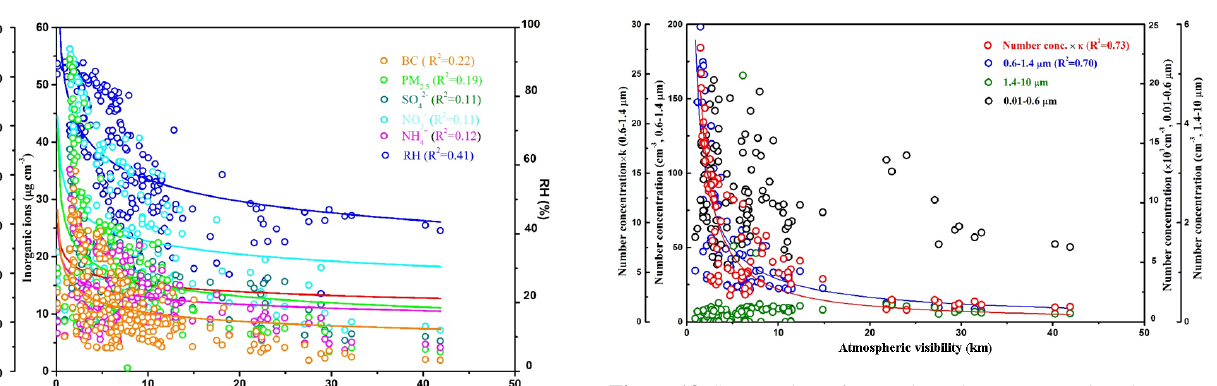
Figure 13. Scatter plots of aerosol number concentrations in ranges of 0.01–0.6, 0.6–1.4 and 1.4–10µm, and aerosol number concen- tration multiplied by particle hygroscopicity (kappa value, κ) vs. atmospheric Density